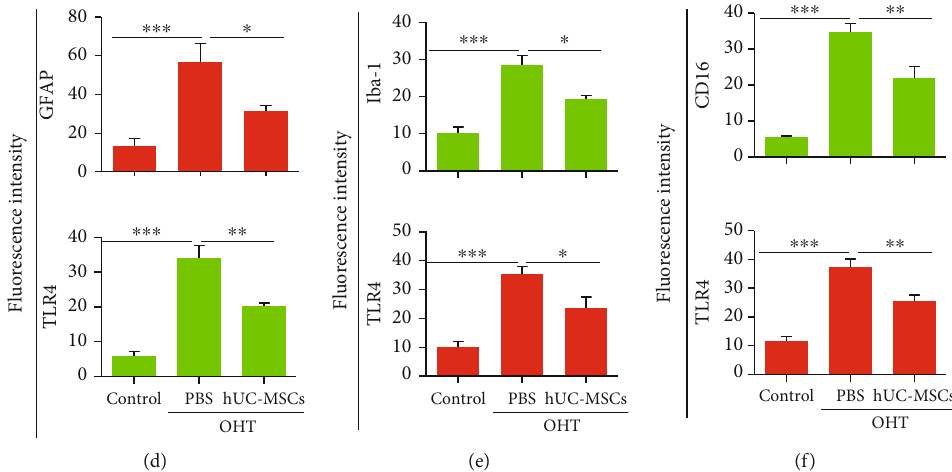
Figure 4: hUC-MSC transplantation modulates glial cell reactivity and TLR4 expression in the retinas of OHT-induced rats. Two weeks after hUC-MSC injection. (a) Double immunostaining of astrocytic marker GFAP (red) and TLR4 (green) in the control group, the PBS-treated OHT group, and the hUC-MSC-treated OHT group. Astrocyte activation was assessed by GFAP. TLR4 was colocalized in Müller cells and astrocytes (yellow). (b) Double immunostaining of microglial marker iba-1 (green) and TLR4 (red) in the control group, the PBS-treated OHT group, and the hUC-MSC-treated OHT group. TLR4 was poorly colocalized in iba-1-positive microglia. (c) Double immunostaining of active microglial marker CD16 (green) and TLR4 (red) in the control group, the PBS-treated OHT group, and the hUC-MSC-treated OHT group. TLR4 was colocalized in active microglia. (d) Fluorescence intensity of GFAP and TLR4 ( n = 4/group ; ∗ P < 0 : 05 , ∗∗ P < 0 : 01 , and ∗∗∗ P < 0 : 001 compared with one-way ANOVA with Turkey ’ s post hoc tests). (e) Fluorescence intensity of iba-1 and TLR4 ( n = 4/group ; ∗ P < 0 : 05 and ∗∗∗ P < 0 : 001 compared with one-way ANOVA with Turkey ’ s post hoc tests). (f) Fluorescence intensity of GFAP and TLR4 ( n = 4/group ; ∗∗ P < 0 : 01 and ∗∗∗ P < 0 : 001 compared with one-way ANOVA with Turkey ’ s post hoc tests). Scale bar: 50 μ